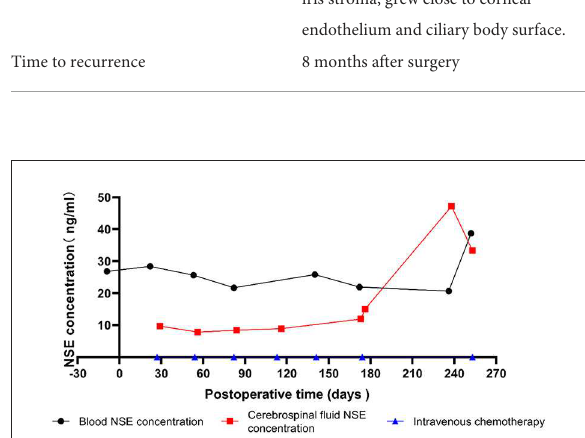
FIGURE2 Levels of neuron specific enolase (NSE) over time in patient that died.